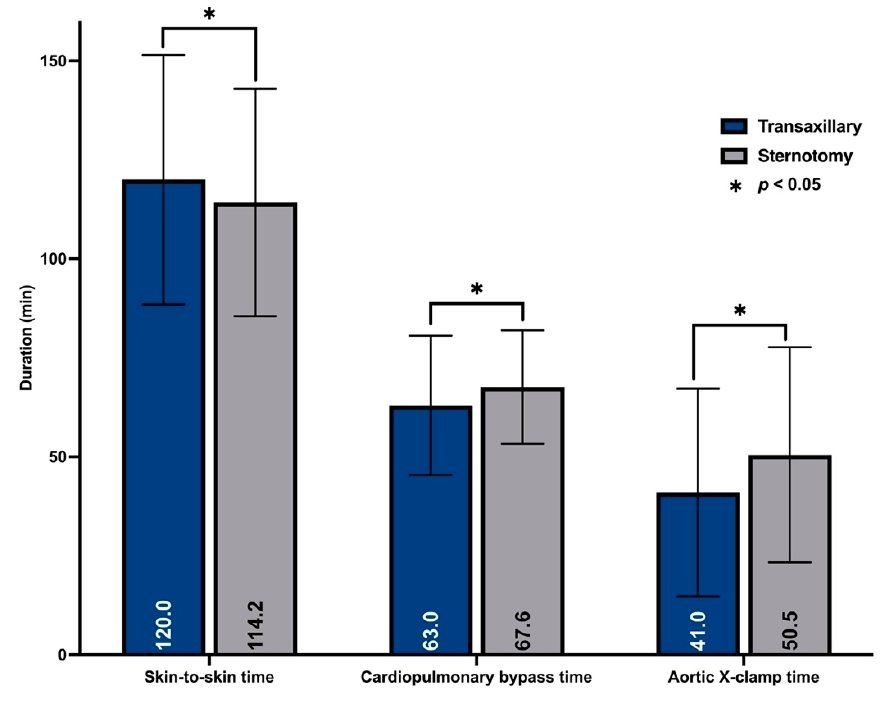
Figure 3. Procedural times.